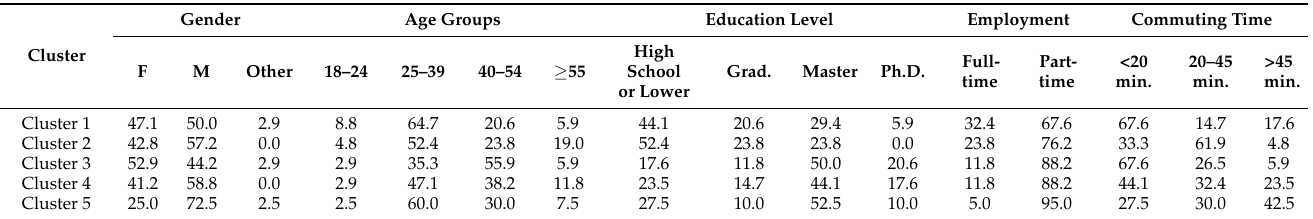
Table 3. Distribution of socio-demographic characteristics across the five clusters (percentages).